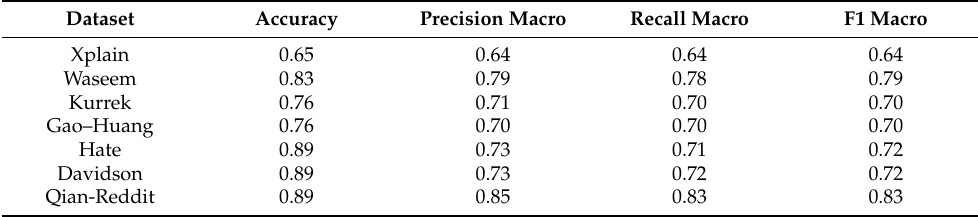
Table A9. Scores obtained on the benchmark Datasets using the CNN-GRU method. The embeddings were made with the help of GloVe